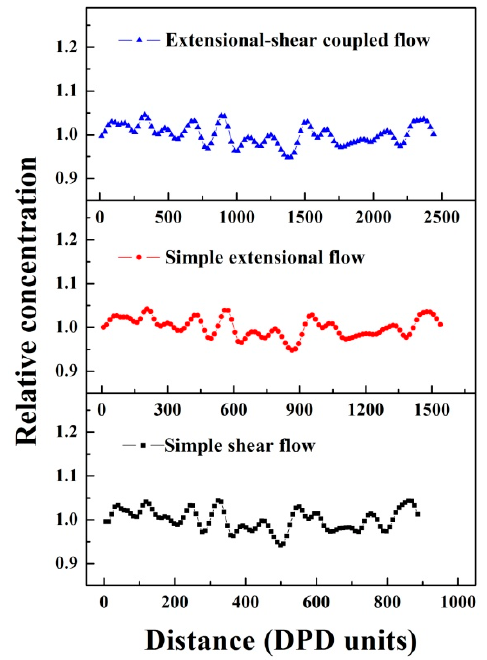
Figure 8. The relative concentration distribution of PA6 along Z direction under simple shear flow, simple extensional flow and extensional–shear coupled flow.